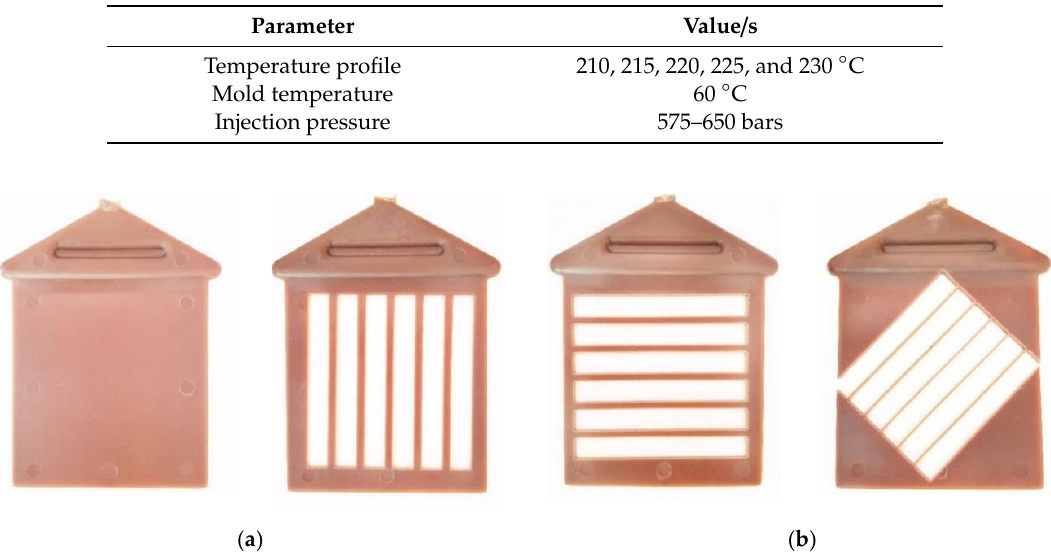
Figure 4. ( a ) Square sample with dimension 70 × 70 × 1.5 mm, and ( b ) Square samples from which oriented specimens are laser cut, (from left to right) parallel (0°), perpendicular (90°) and 45° oriented